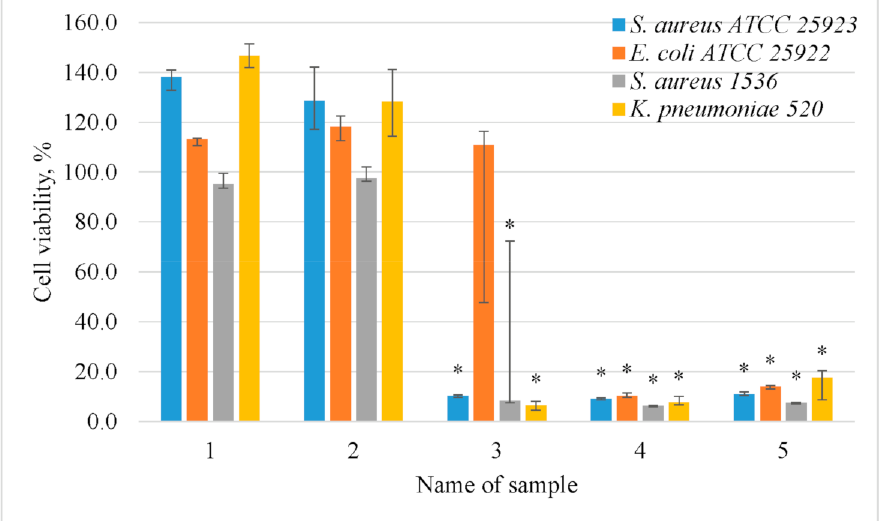
Figure 3. Bacterial cell survival after subculturing with yeast extract by MTT test. The yeast extracts were obtained from samples of yeast S. cerevisiae 71B, cultured in 20% glucose solution with the addition of: (1) sterile dH 2 O, (2) 0.5 mM AgNO 3 , (3) 1.0 mM ANO 3 , (4) 1.5 mM AgNO 3 and (5) 2.0 mM AgNO 3. * p < 0.05.